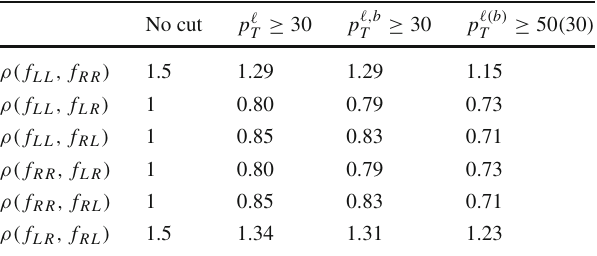
Table 1 Normalised distance between the templates for different helic- ity combinations at the parton level, without kinematical cuts and with cutsonthetransversemomentaofthechargedleptonand b quark(trans- verse momenta are in